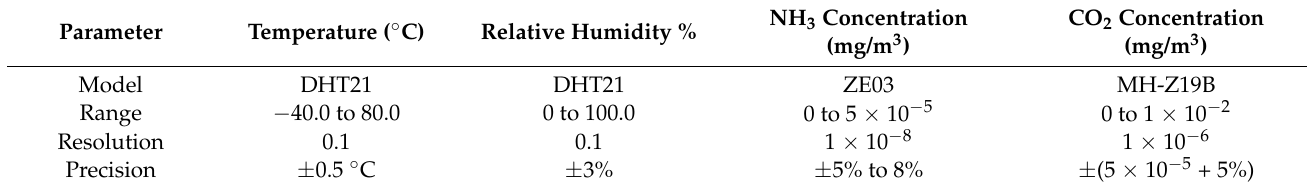
Table 1. Parameters of the wireless sensor slave node components.